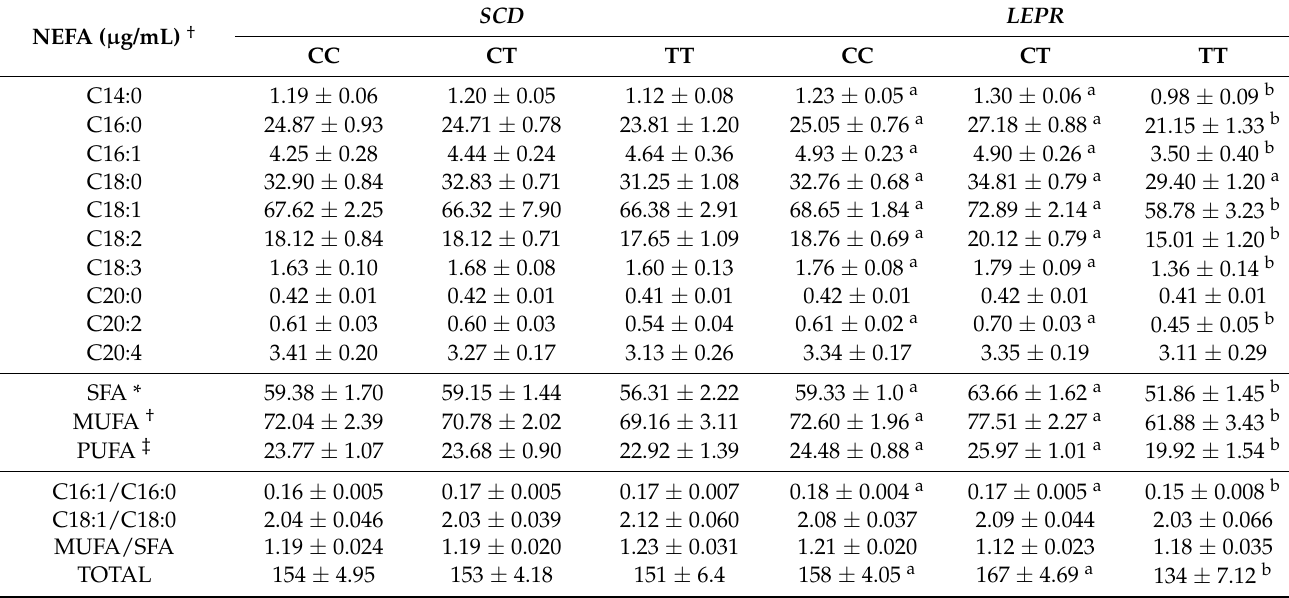
(Supplementary Table S2). Their effects on circulating NEFA after fasting are given in Table 3. Table 3. Absolute levels of circulating non-esterified fatty acids by SCD and LEPR